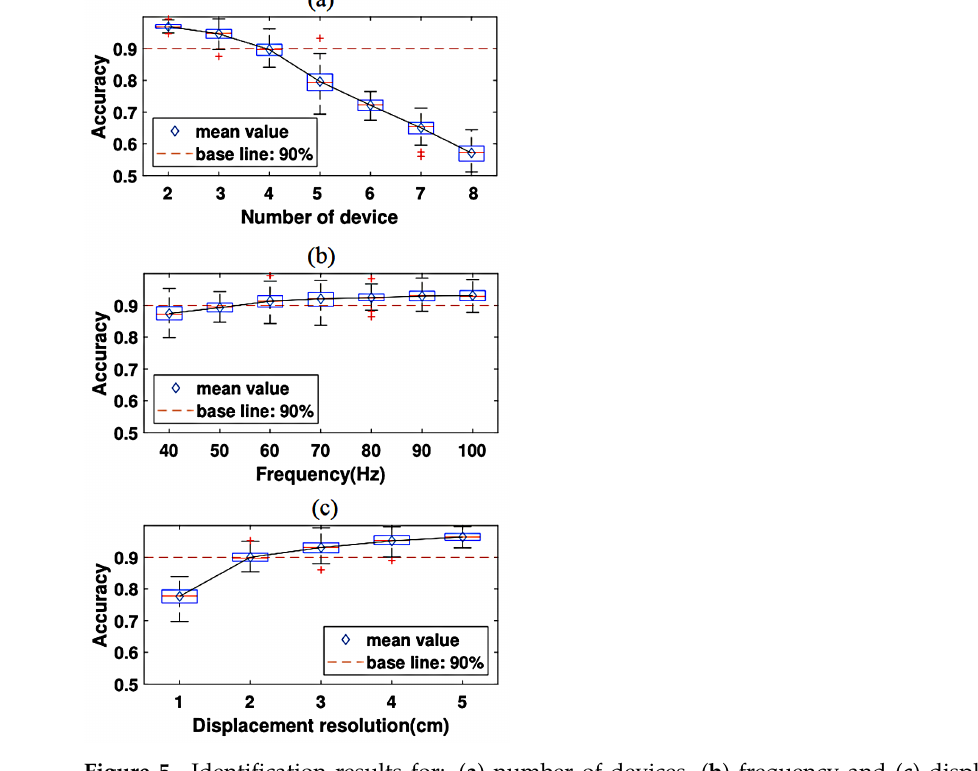
Figure 5. Identification results for: ( a ) number of devices, ( b ) frequency and ( c ) displacement resolution